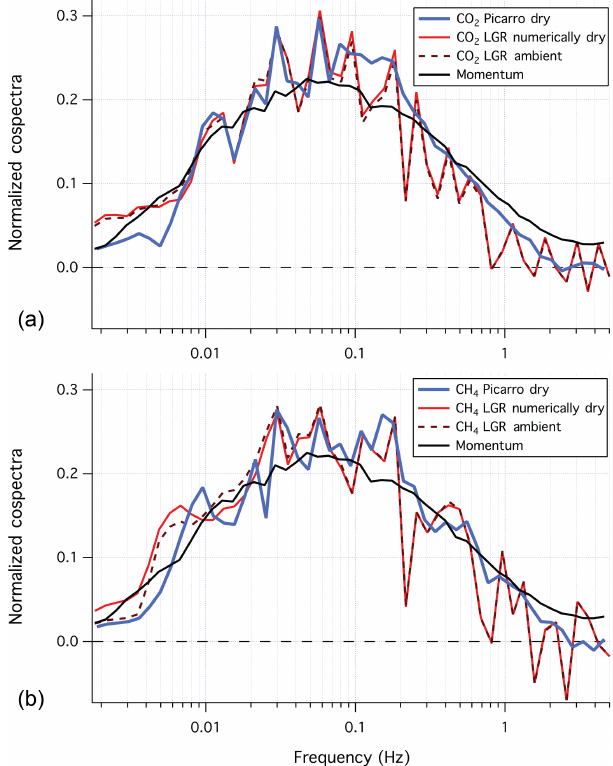
Figure 6. Mean cospectra of CO 2 (top), CH 4 (bottom) with mo- mentum for the air–water wind sector of 45 to 80 ◦ during the Pi- carro (dry) vs. LGR (wet) period, normalised by the respective mean flux. Gas cospectra from the two instruments are similar in the mean and show reasonable agreement with the momentum cospectrum. Spectral similarity suggests high-frequency flux losses of ∼ 6% for CO 2 and ∼ 4% for CH 4 during this